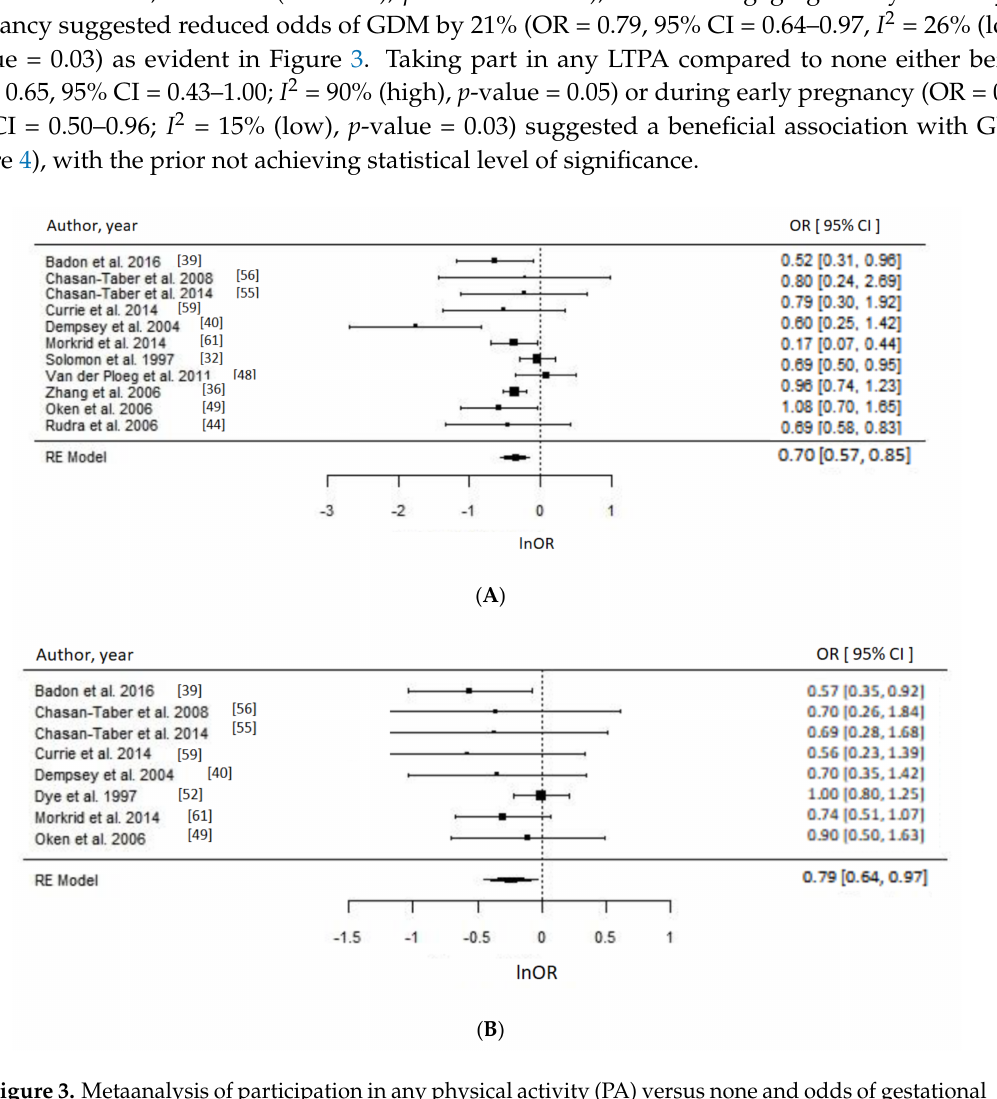
Figure 3. Metaanalysis of participation in any physical activity (PA) versus none and odds of gestational diabetes (GDM). Estimates are expressed as odds ratios (OR) with their corresponding 95% confidence intervals, however x -axis uses lnOR scale. ( A ) Engaging in any PA before pregnancy suggested 30% reduced odds of GDM (OR = 0.70, 95% CI = 0.57–0.85; I 2 = 52% (Medium), p -value = 0.0006); ( B ) Engaging in any PA during early pregnancy suggested 21% lower odds of GDM (OR = 0.79, 95% CI = 0.64–0.97, I 2 = 26% (low), p -value =